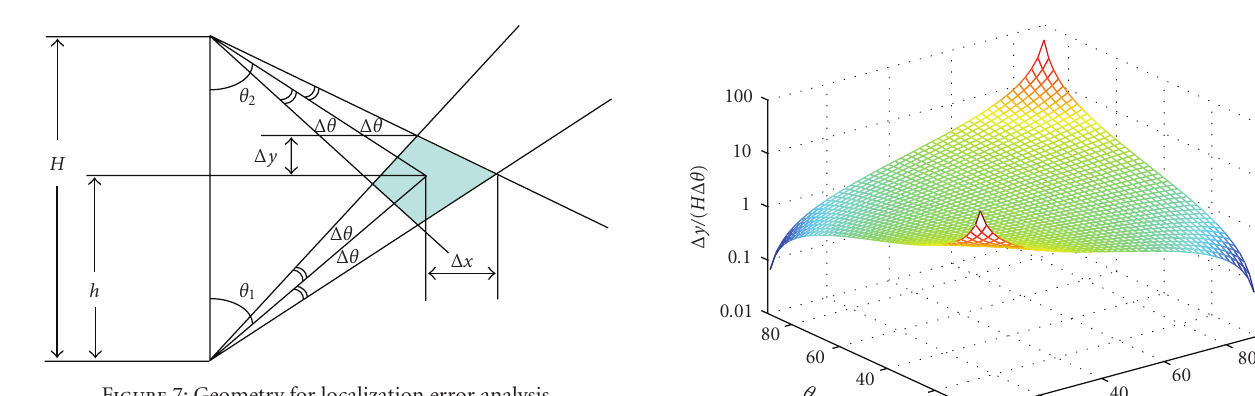
Figure 7: Geometry for localization error analysis.